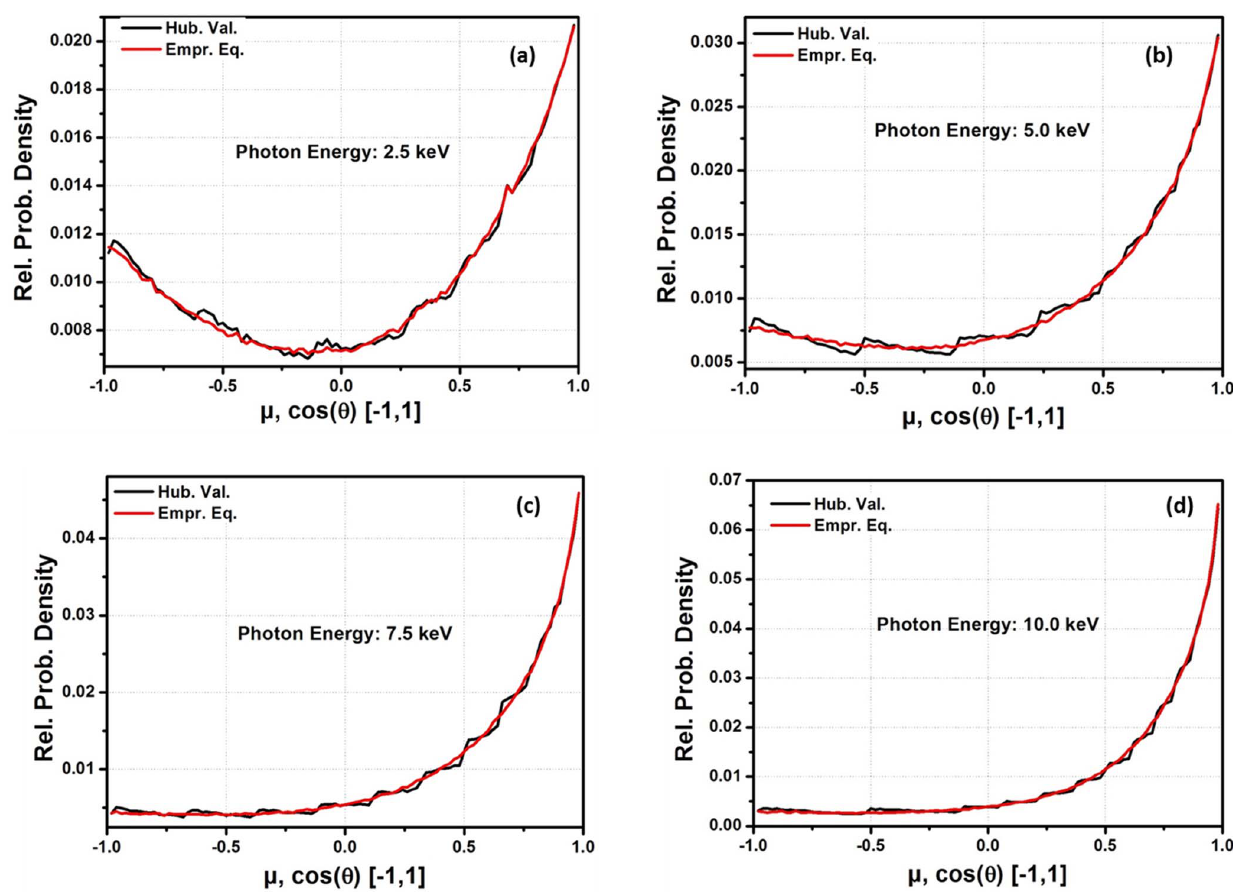
Figure 4. Angle distribution of coherently scattered photons for a source of 1 million photons by using F H ( q i , Z ) for ‘ q ’ from 0 to 16.0 A˚ 2 1 and Empirical equation data for Sodium (Na, Z=11) as a scatter element. (a) energy=0.0025 MeV, (b) energy=0.005 MeV, (c) energy=0.0075 MeV, (d) energy=0.01 MeV.